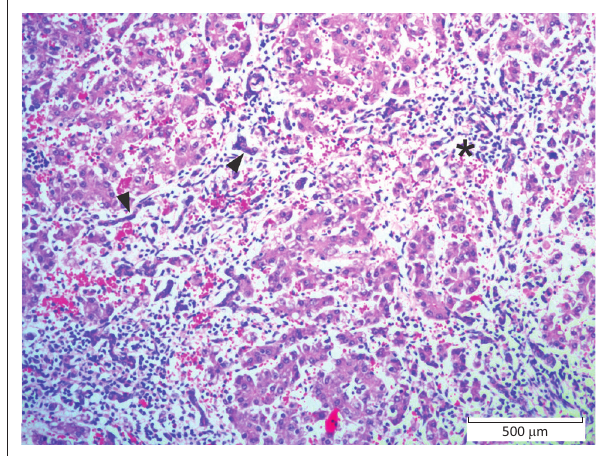
FIGURE 2: Liver, African buffalo. Hepatic ductal plate abnormality present at birth. Note the periportal lymphoplasmacytic inflammation ( * ) and multiple undeveloped bile ductules (arrowheads). Haematoxylin and